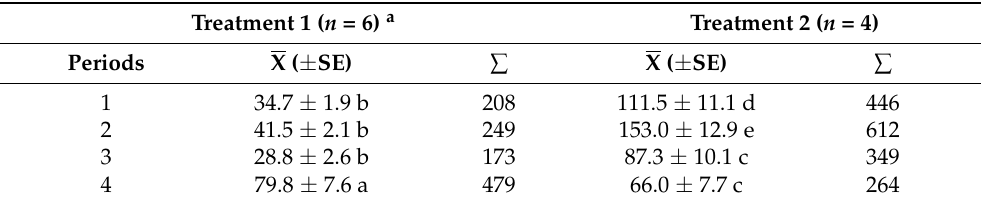
Means in the columns followed by the same letter are not significantly different ( p = 0.05; Tukey’s Studentized Range Test; SAS 2001). Because it was not possible to conduct treatments in pairs on the same nights, data between treatments were not compared statistically. a Treatment 1 = CO 2 -baited CDC 1012 trap always present, horse present in periods 1–3, not present in period 4 ( n = 6). Treatment 2 = CO 2 -baited CDC 1012 trap always present, horse never present ( n =